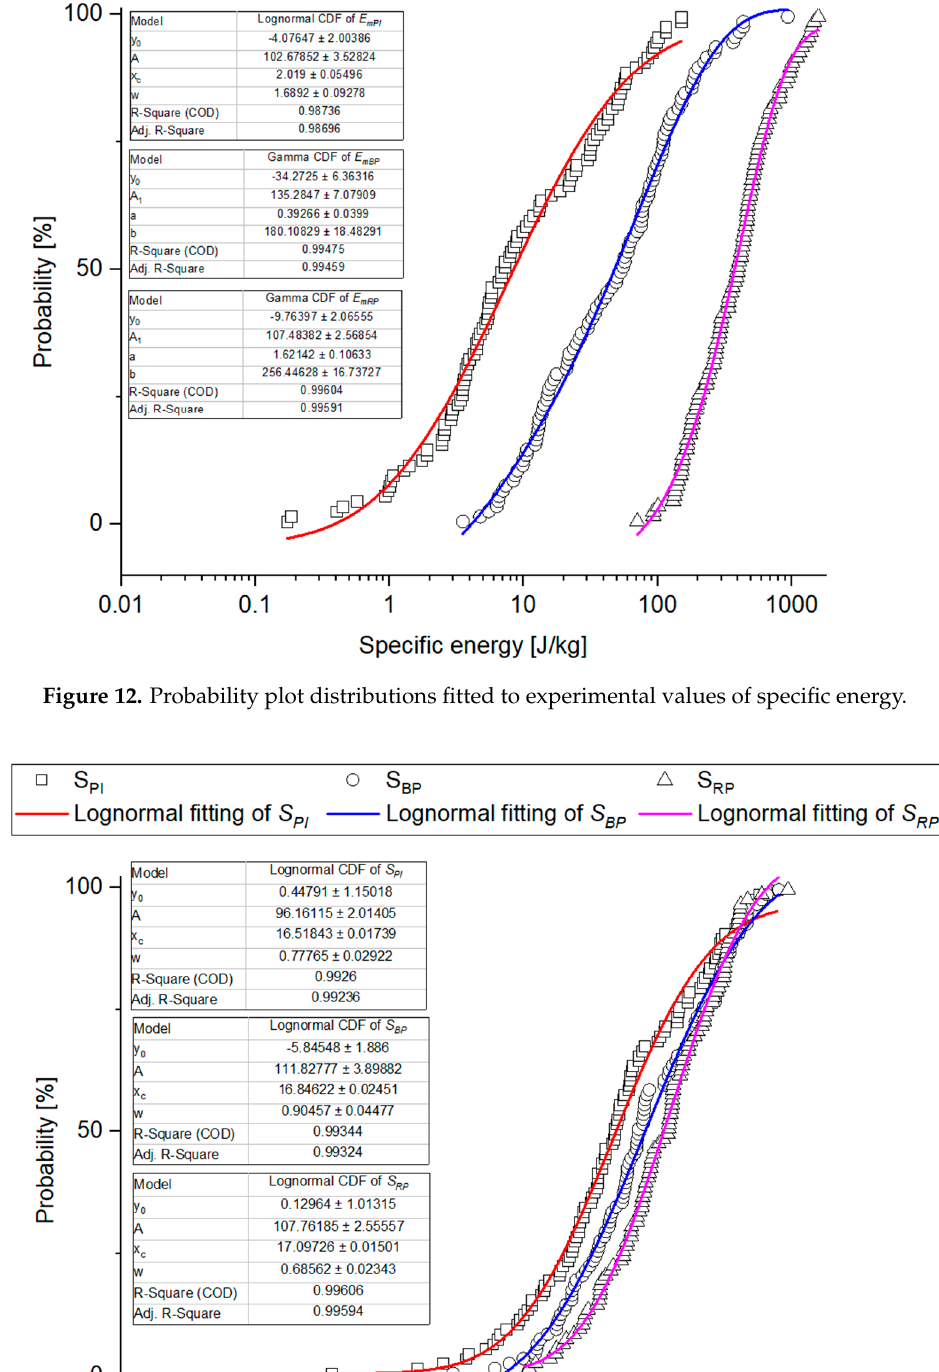
Figure 11. Probability plot distributions fitted to experimental values of forces.